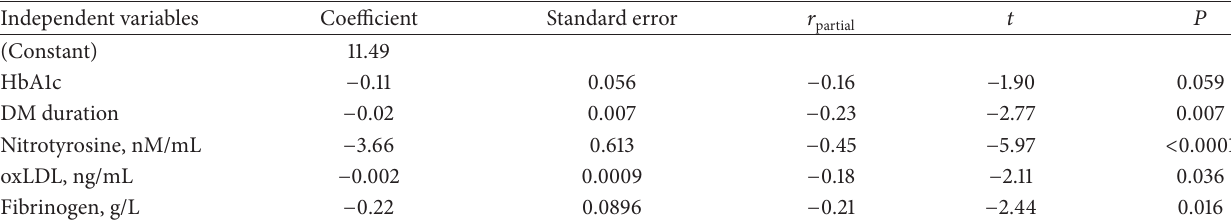
Table 4: Multivariate regression, dependent variable 𝐾 𝑠 .